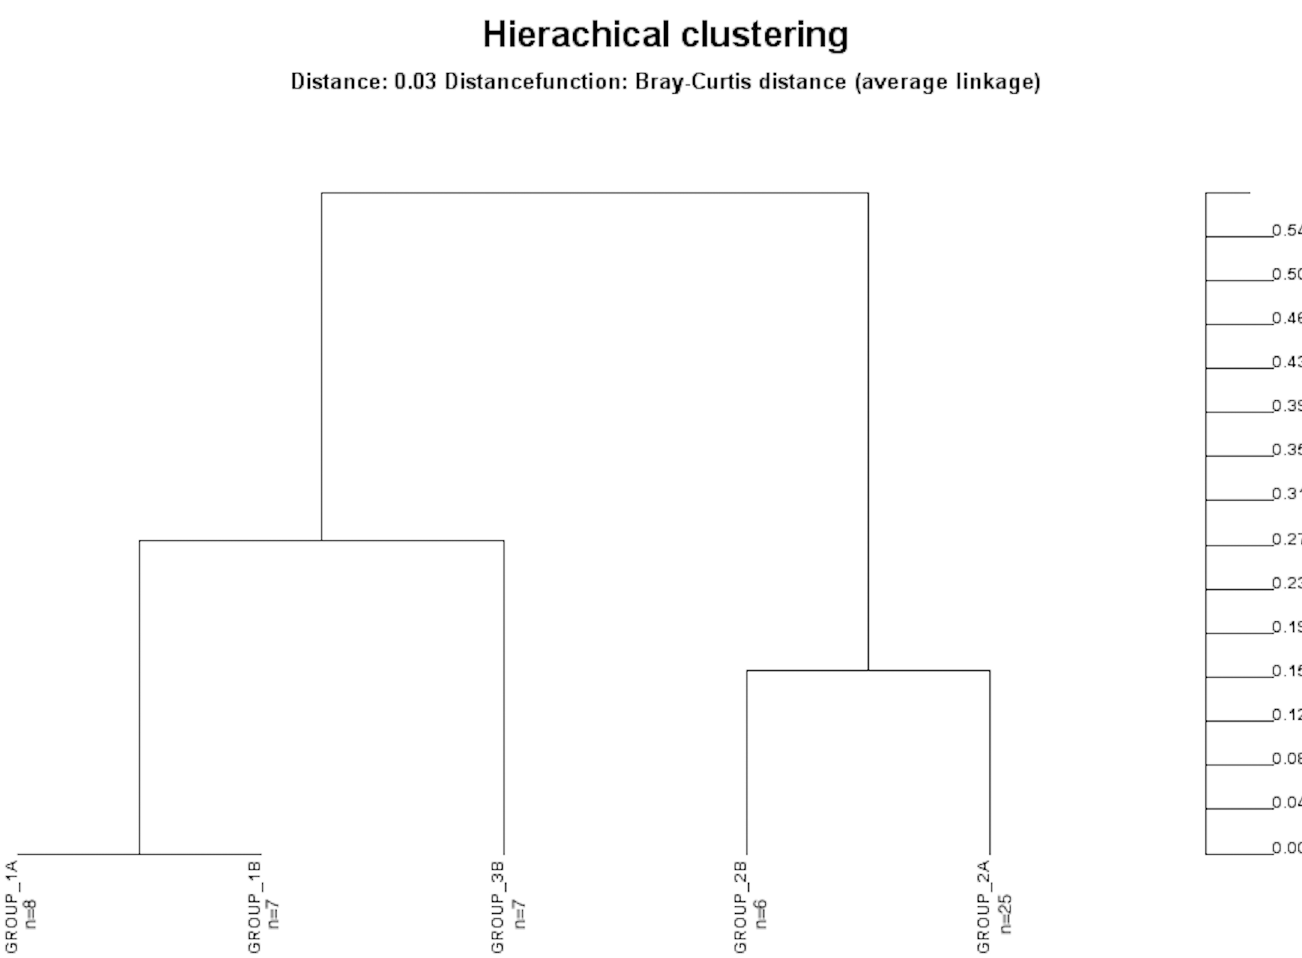
Fig 6. Bray-Curtis distances between study groups indicating differences in bacterial species composition. Distance of zero indicates that groups are completely similar for every species. Distance of 1 indicates that groups are completely dissimilar and do not share any species. Group 1a, healthy adults; group 1b, healthy respiratory tract but with antibiotic therapy for extrapulmonary infection; group 2a, non-neutropenic intubated and mechanically ventilated ICU patients without antibiotic therapy; group 2b, non-neutropenic intubated and mechanically ventilated ICU patients with antibiotic therapy for extrapulmonary infection; group 3b, non-neutropenic intubated and mechanically ventilated ICU patients with antibiotic therapy due to